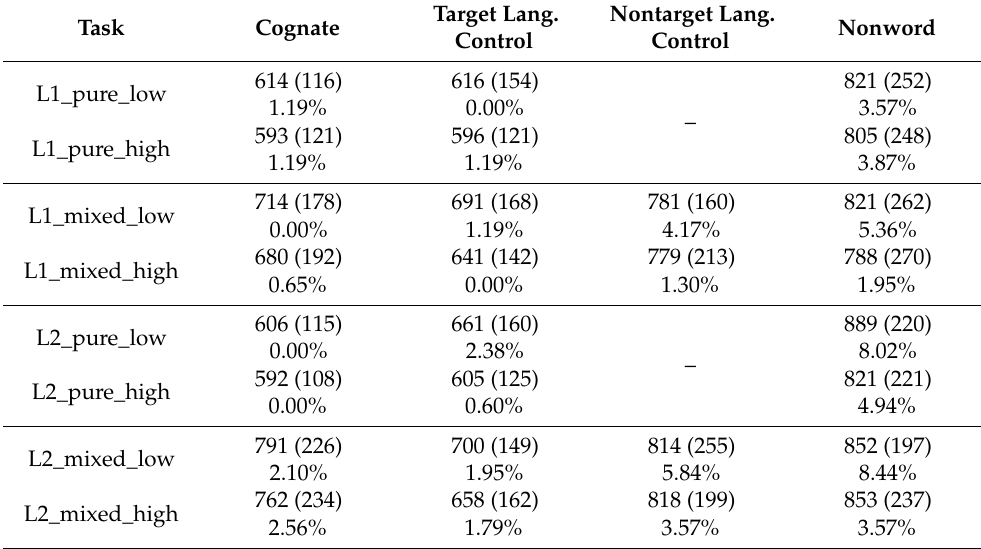
Table 7. Mean reaction times (ms) with standard deviations (ms) and error rates (%) for item categories in the four tasks for low- and high-proficiency groups. Target Lang. Nontarget Lang. Task Cognate Control